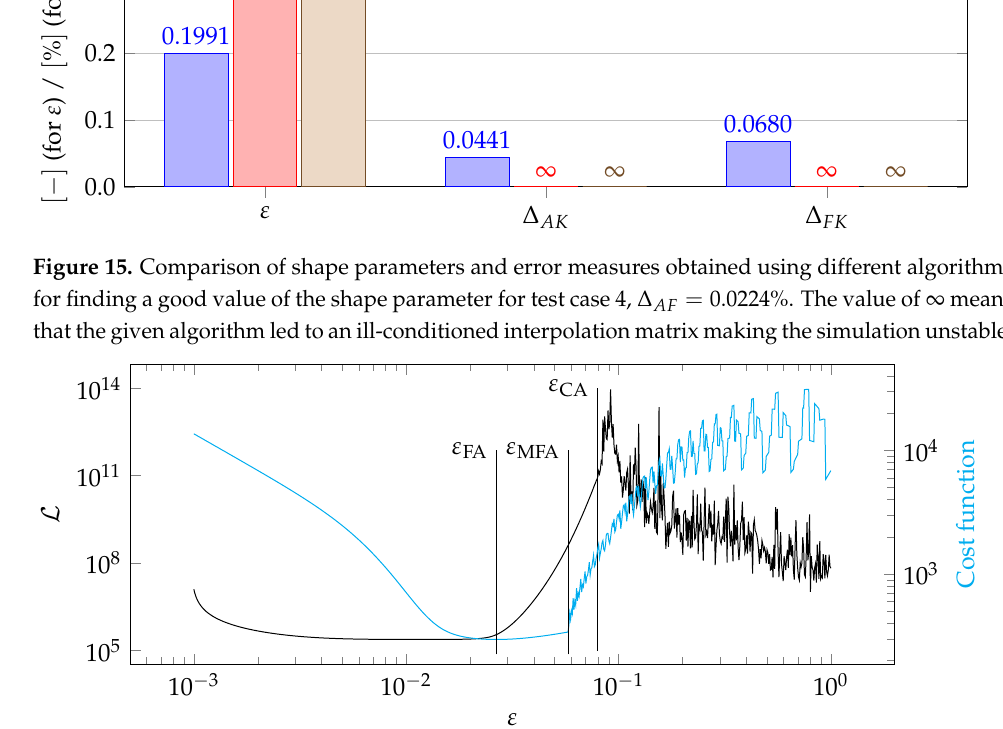
Figure 16. Graphs of the function L ( ε ) and the cost function for test case